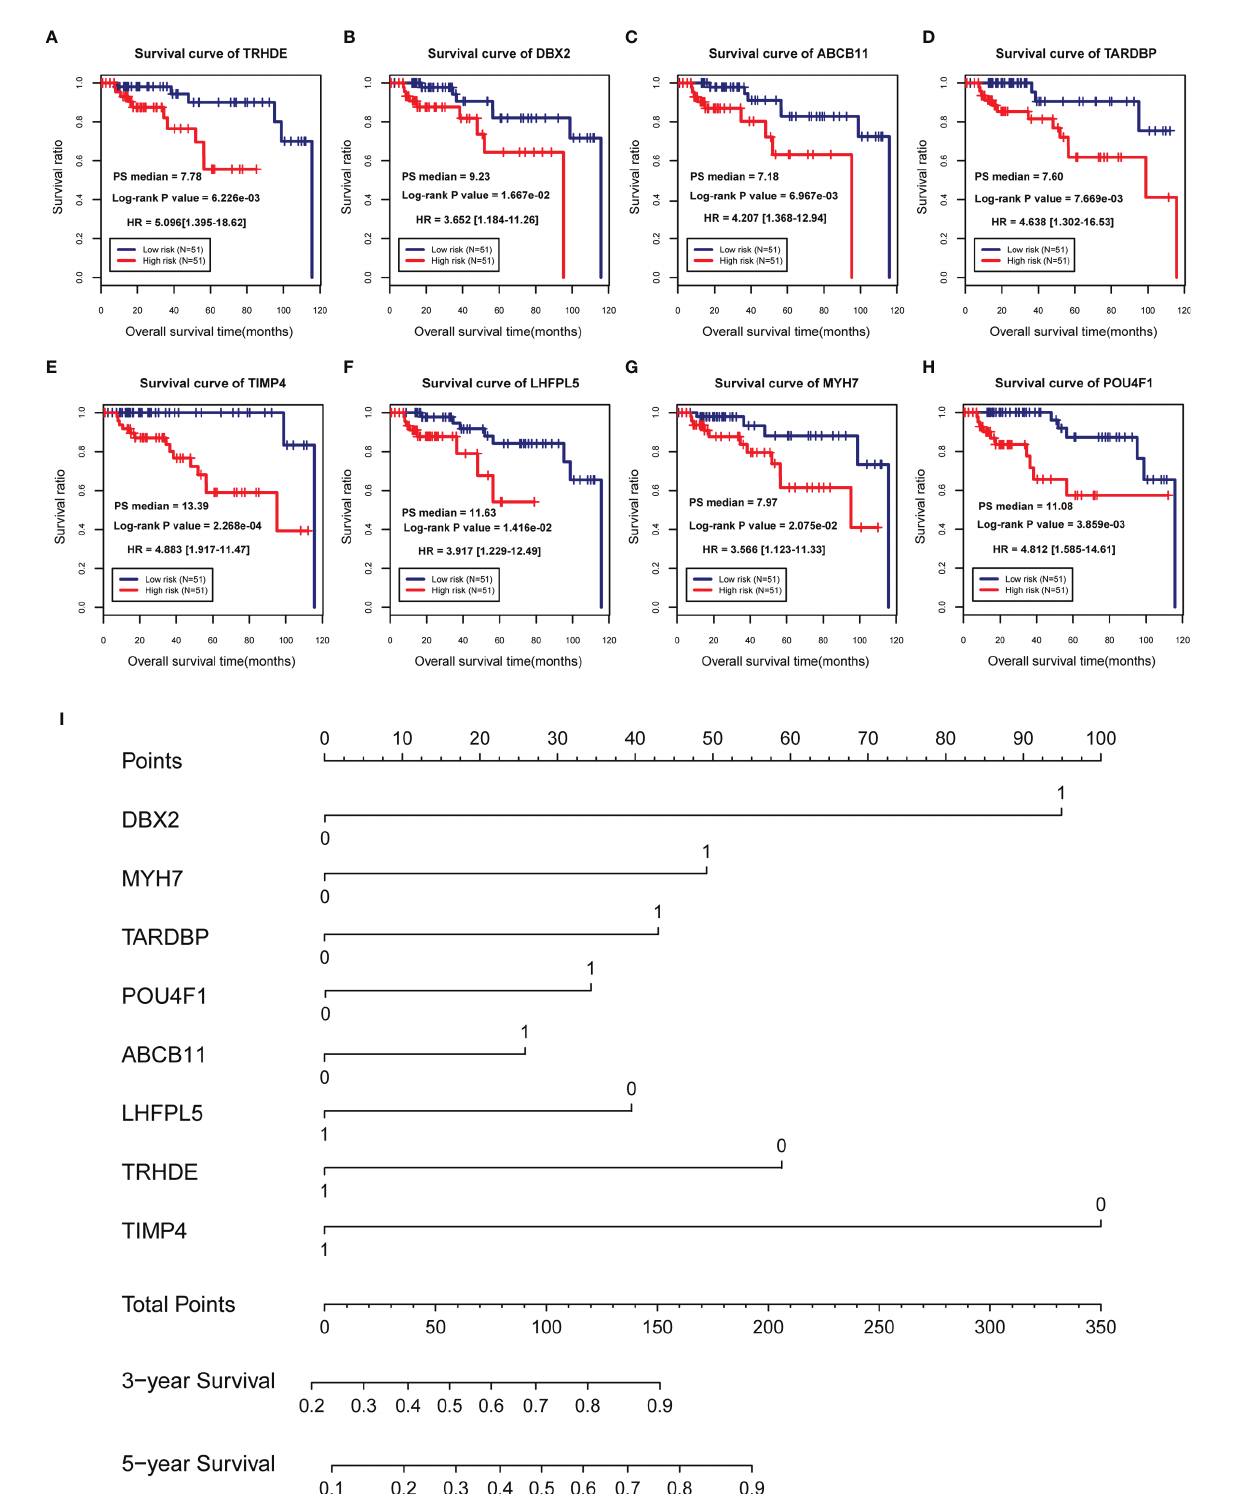
Frontiers in Oncology |